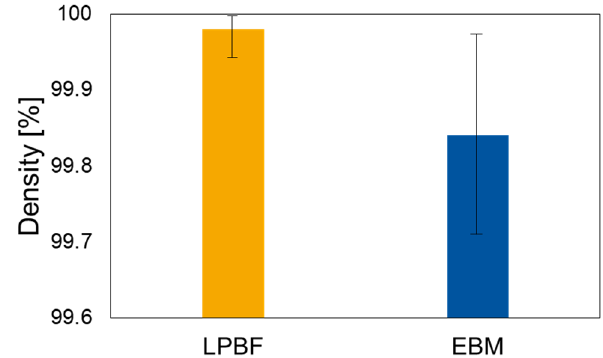
Figure 3. Relative density of LPBF and EBM cubes.